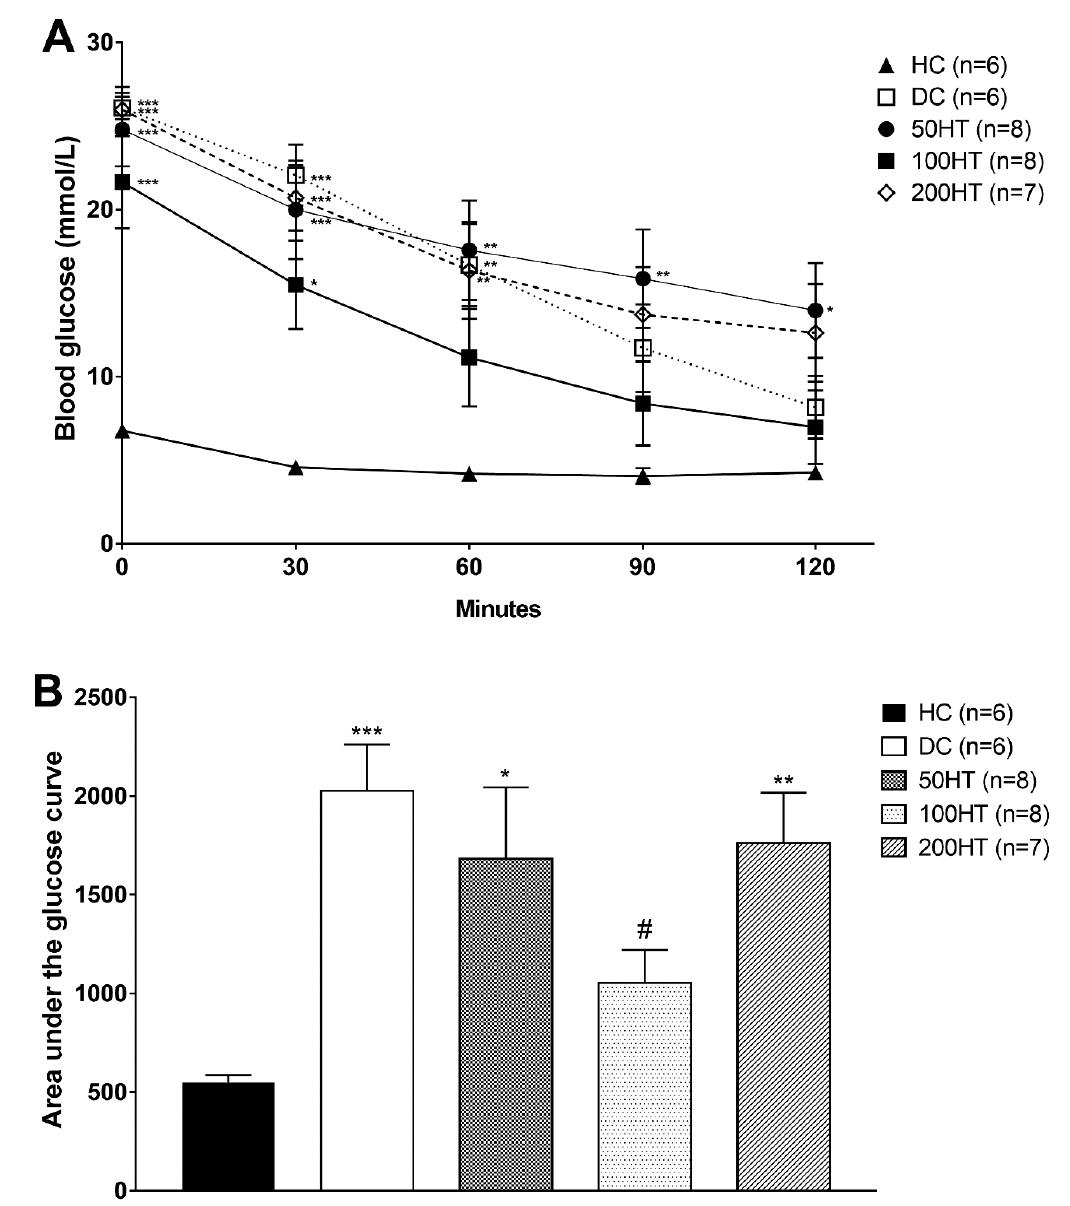
Figure 7. Effect of horsetail on blood glucose levels ( A ) and area under the glucose curve ( B ) during insulin tolerance test. The *, **, and *** indicates significant difference from the HC group ( p < 0.05, p < 0.01, and p < 0.001, respectively). The # indicates significant difference from the DC group ( p < 0.05).